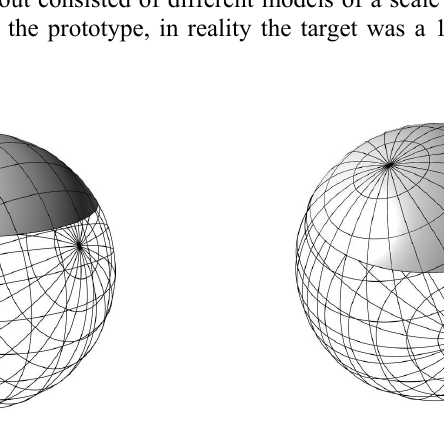
Figure 1: Examples of the design proposals by Mick